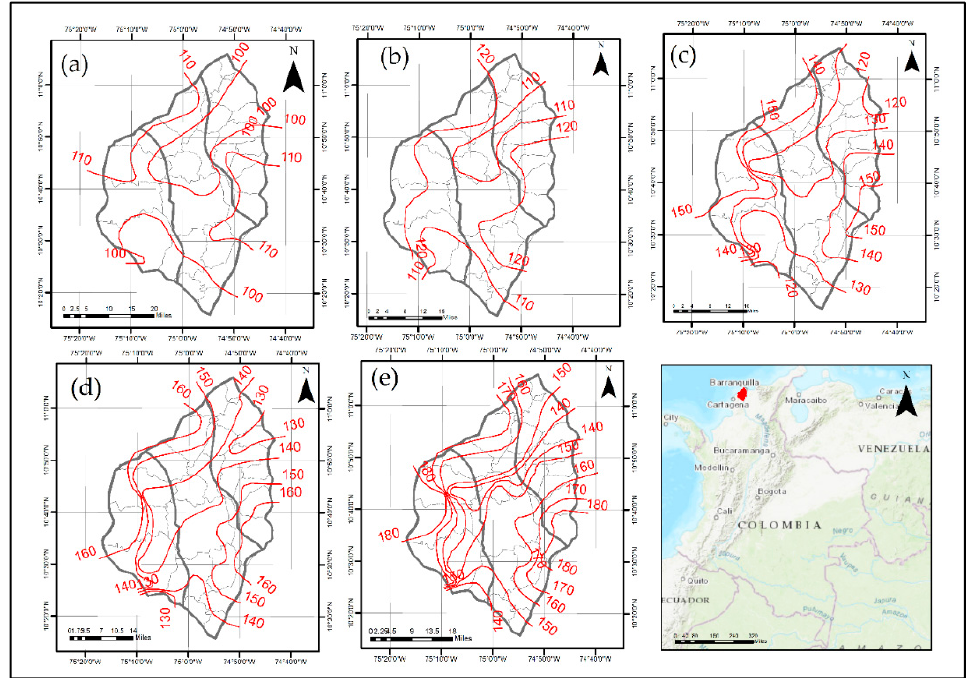
Figure 8 . Stationary conditions (SC) isohyetal maps: ( a ) five years, ( b ) 10 years, ( c ) 25 years, ( d ) 50 years, and ( e ) 100 years.